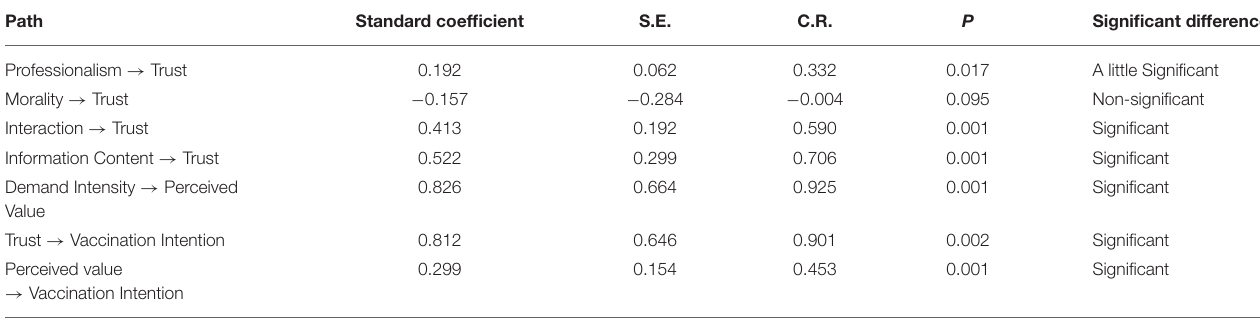
TABLE 4 | Test of significance of path coefficients of assumed model